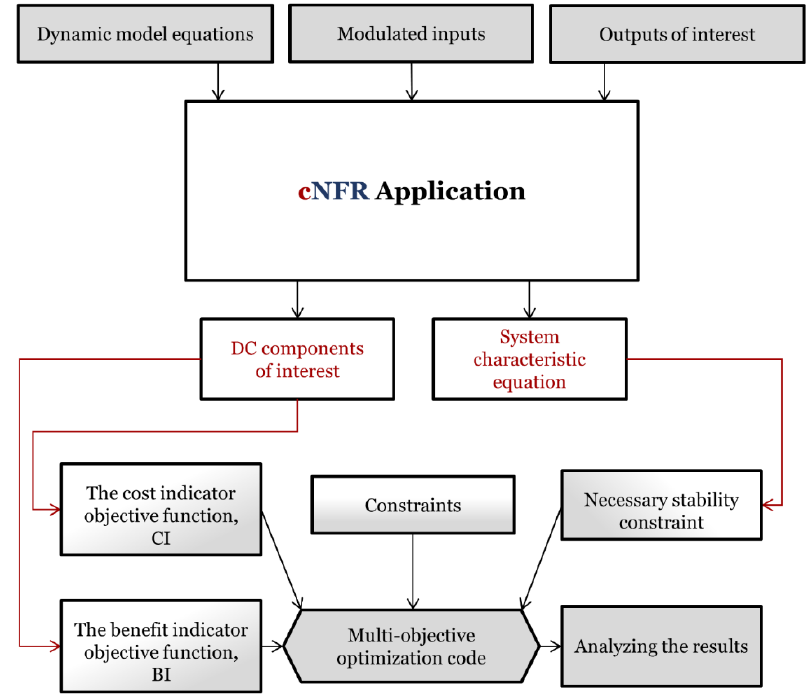
Figure 2. The computer ‐ aided Nonlinear Frequency Response–Multi ‐ Objective Optimization (cNFR– MOO) methodology with the user ‐ required steps (gray rectangles) and steps automatically done by the application (white